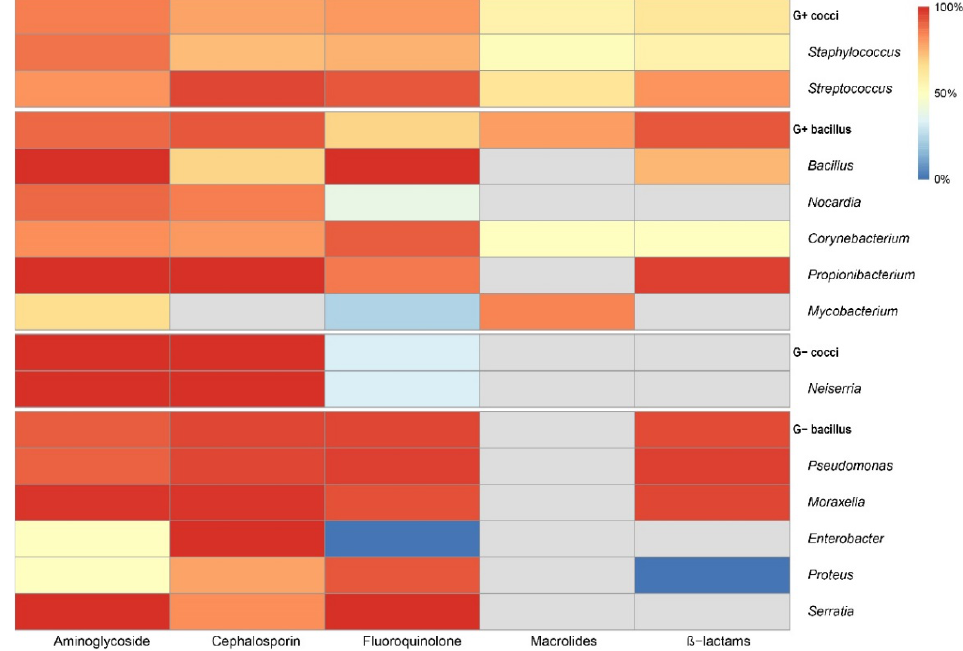
Figure 5. Results of drug susceptibility test of the strains isolated from corneal lesions.